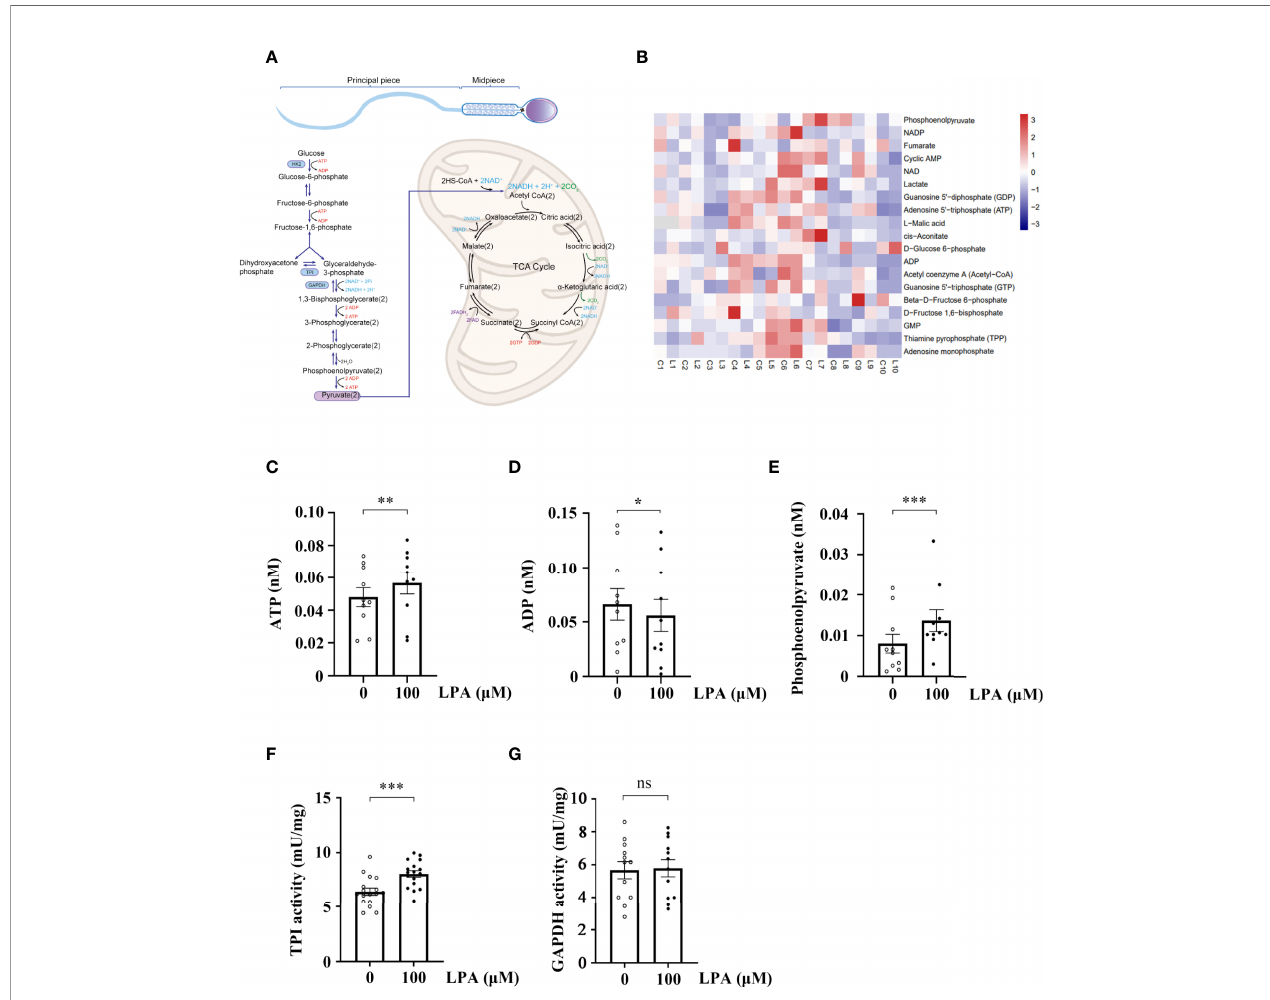
FIGURE 4 | Lysophosphatidic acid (LPA) accelerates sperm glycolysis. (A) Diagram depicting energy production in sperm. (B) Heatmap of the metabolite status in sperm treated by LPA. The sperm sample from a single person were divided into two equal parts, and spermatozoa were treated with LPA (0 and 100 µM) for 1 h in the Biggers, Whitten, and Whittingham (BWW) medium and collected for targeted glycometabolomics ( n = 10). C: control, L: LPA (100 µM). The x-axis represents the comparative change of each sperm sample before (C1-10) and after (L1-10) LPA treatment. (C – E) The levels of ATP (C) , ADP (D) , and phosphoenolpyruvate (E) in spermatozoa treated with LPA (0 and 100 µM) for 1 h in BWW medium. Data are presented as mean ± SEM. n = 10. * p < 0.05 and ** p < 0.01, *** p < 0.001 compared with the corresponding control (0 µM). (F) Change in triosephosphate isomerase (TPI) activity in sperm before and after LPA treatment. Data are presented as mean ± SEM. n = 17. *** p < 0.001 compared with the corresponding control (0 µM). (G) Change of glyceraldehyde-3-phosphate dehydrogenase (GAPDH) activity in sperm before and after LPA treatment. Data are presented as mean ± SEM. n = 12. ns: there was no statistical signi fi cance compared with the corresponding control (0